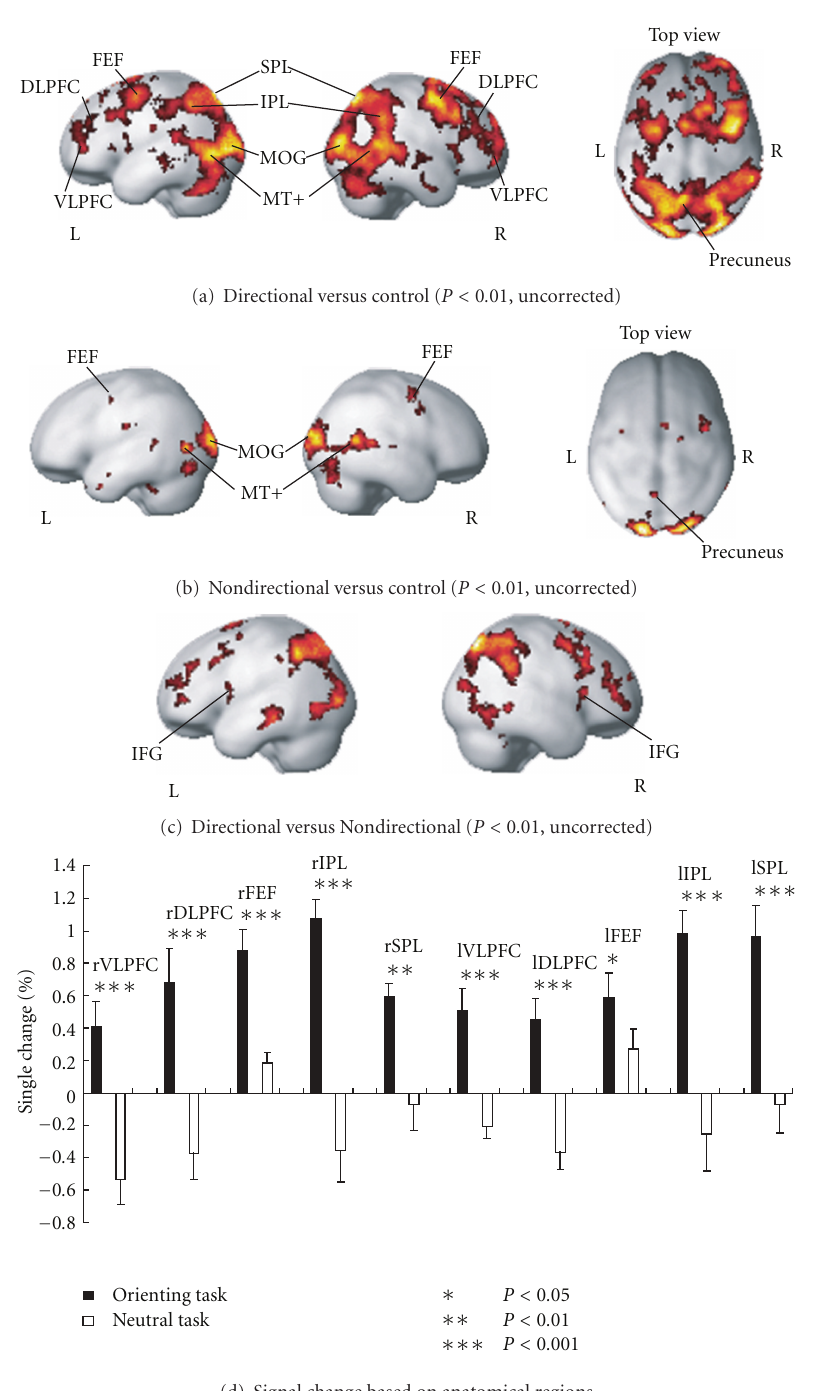
Figure 2: SPM results of (a) Directional task ( P < 0 . 01, uncorrected, cluster size > 0 voxels) and (b) Nondirectional task ( P < 0 . 01, uncorrected, cluster size > 0 voxels). A bilateral frontoparietal network is shown as a result of the Directional task, which is the same as the VLPFC. (c) Brain activation obtained by contrasting the Directional task and the Nondirectional task. (d) Regional BOLD signal change based on anatomical masks. L/l: left hemisphere, R/r: right hemisphere, SPL: superior parietal lobule, IPL: inferior parietal lobule, FEF: frontal eye field; DLPFC: dorsolateral prefrontal cortex, VLPFC: ventrolateral prefrontal cortex, MOG: middle occipital gyrus, MT+: middle temporal and superior temporal cortex, IFG: inferior frontal